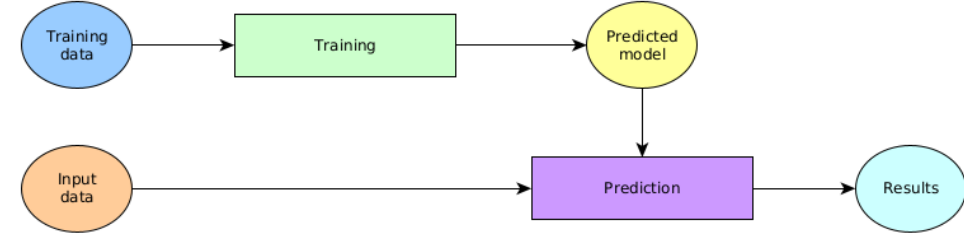
Figure 1. Schematic representation of a machine learning